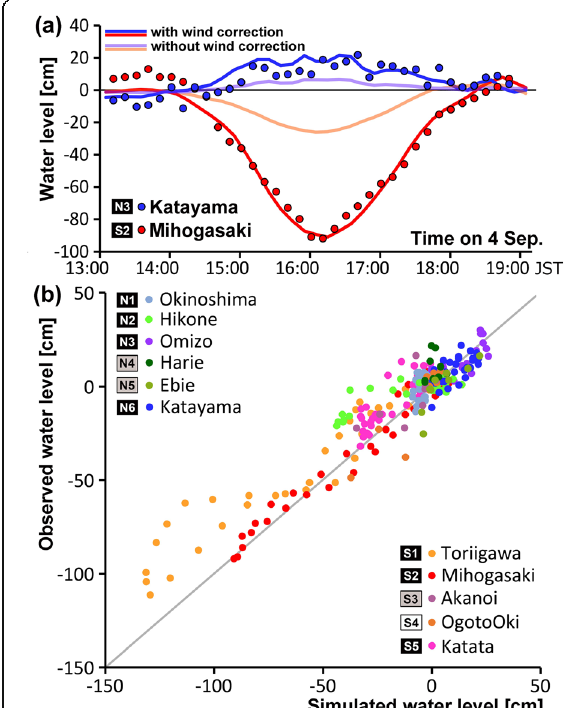
Fig. 9 a Temporal variation reflected in snapshots taken every ten minutes of the observed (colored dots) and simulated (colored lines) water levels in the cases with/without wind correction at the Mihogasaki (red) and Katayama (blue) gauge stations corresponding to S2 and N2, respectively, as shown in Fig. 1. b Scatter plots showing the observed and simulated water levels during the period of 14:00 – 19:00 JST on 4 September. The colors of the dots indicate the eleven gauge stations (N1 – N6, S1 – S5), as shown in Fig.